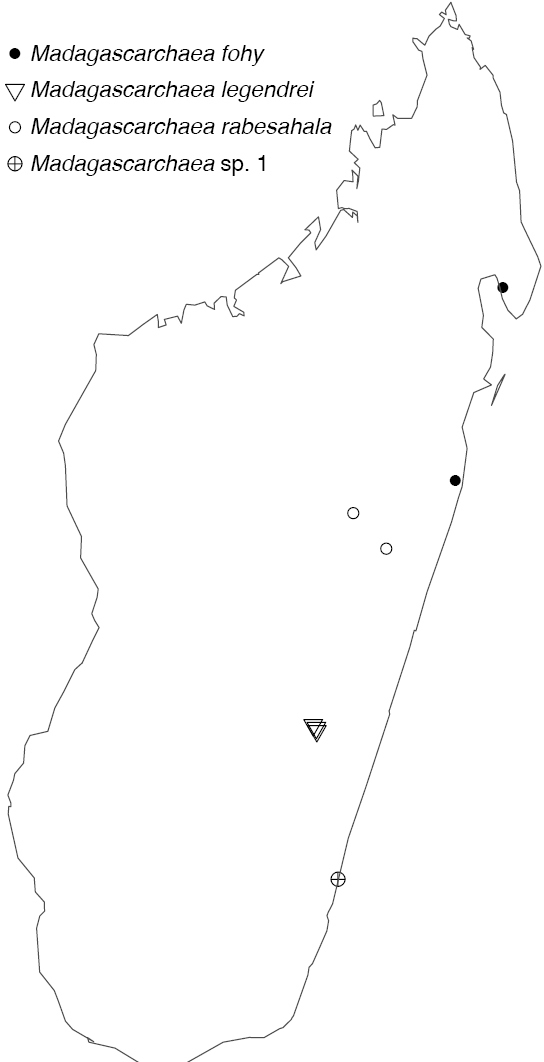
Distribution map for Madagascarchaea species.